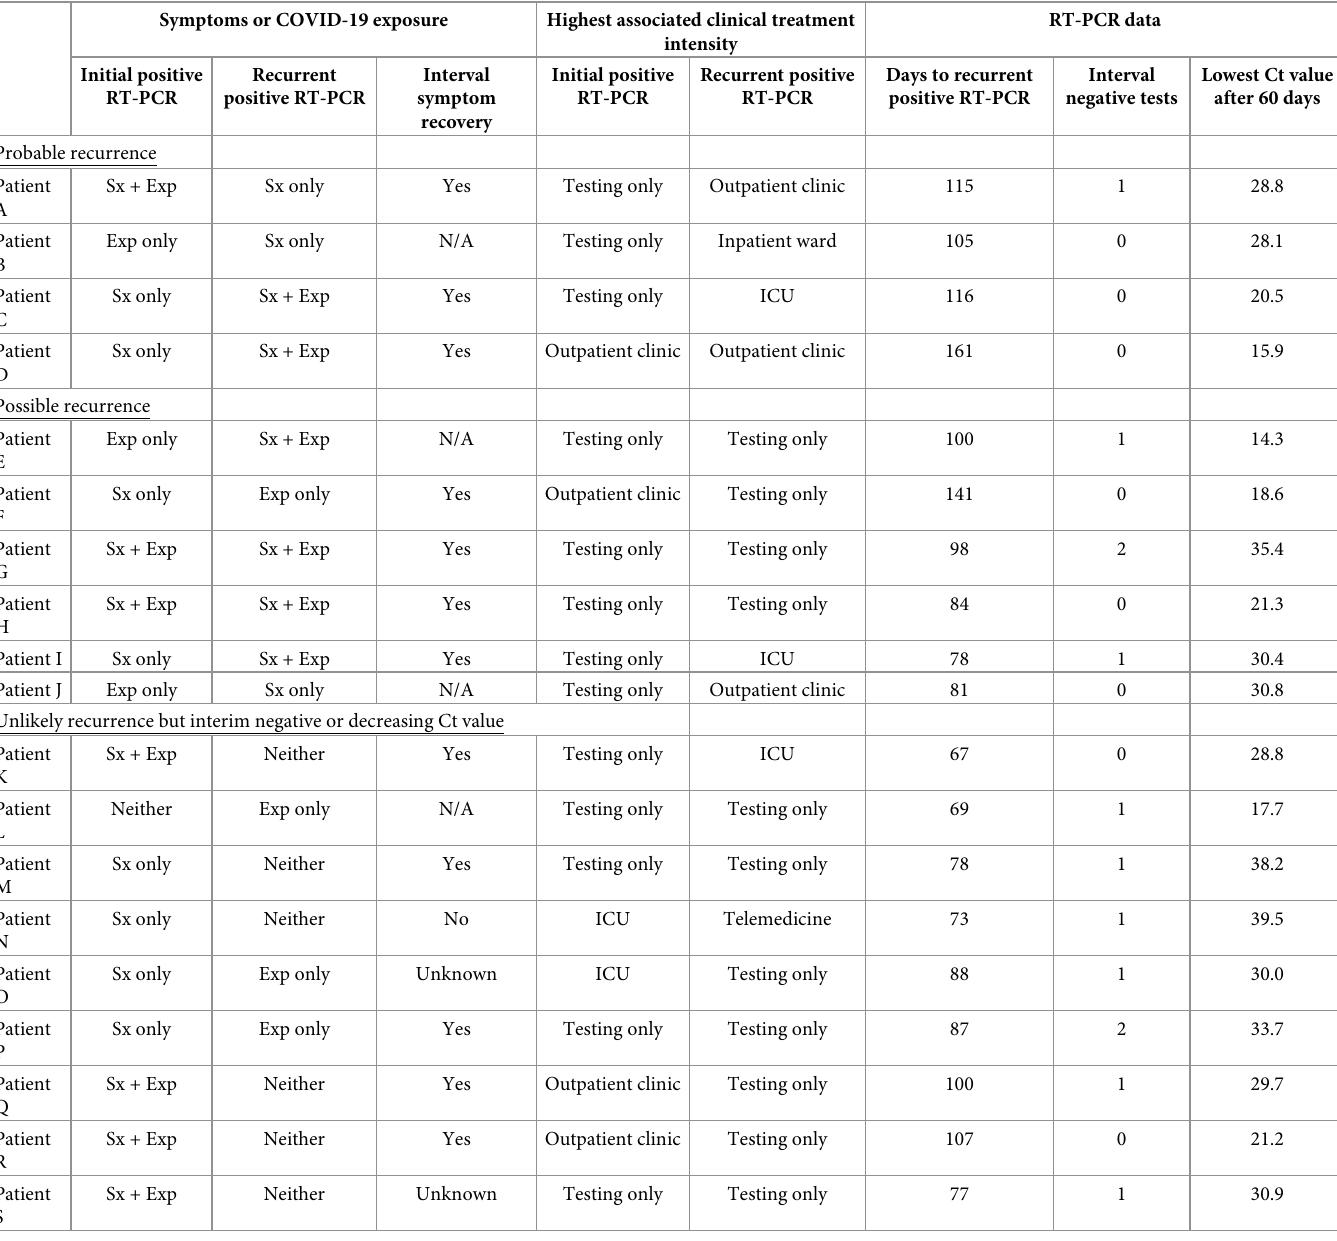
Table 5. Clinical trajectory with interval negative SARS-CoV-2 RT-PCR or decreasing cycle threshold value on repeat RT-PCR. Symptoms or COVID-19